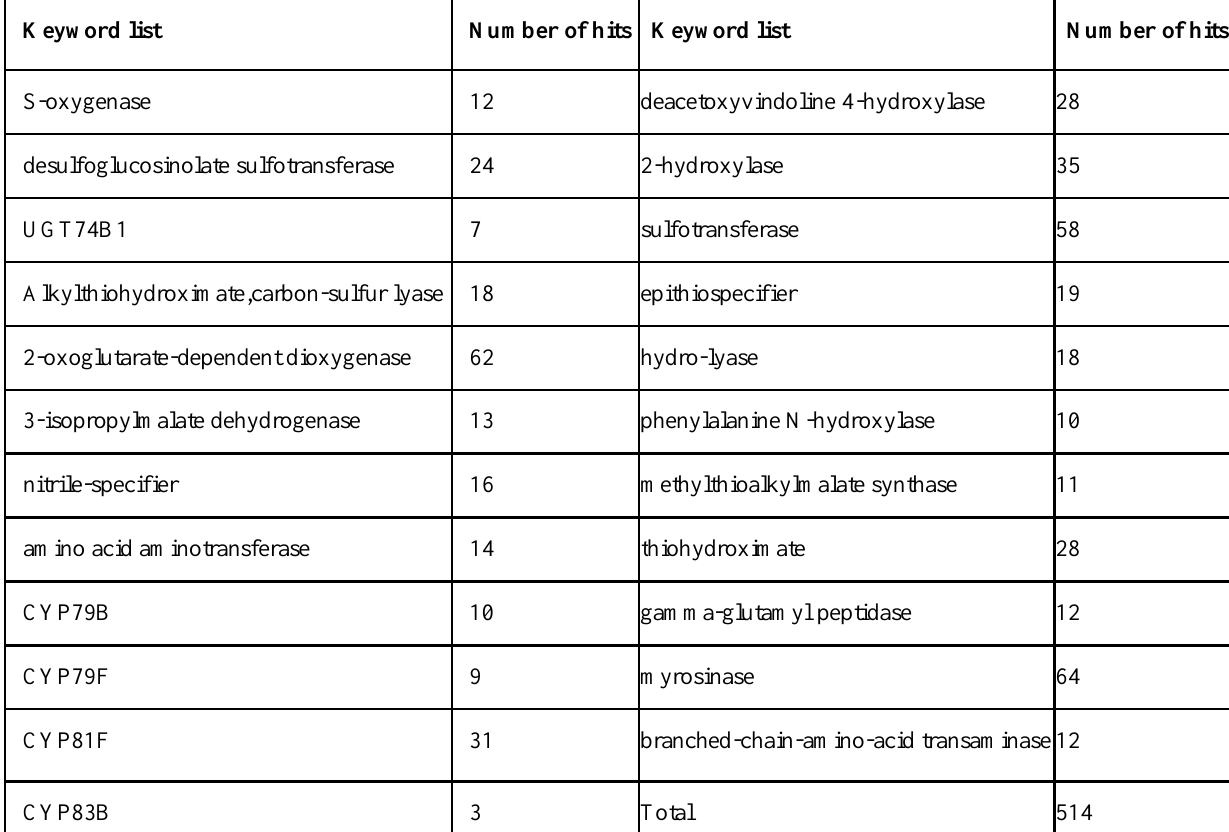
Table S2: Keyword list used in the genomics analysis and the number of matched gene models of each keyword in sequenced B rassica rapa . Terms used here are curated from the pathways glucosinolates are involved in in Arabidopsis thaliana. A complete list of the matched orthologous groups was used instead of the best one assigned to each gene model and the keywords were searched against matched protein member annotations in each